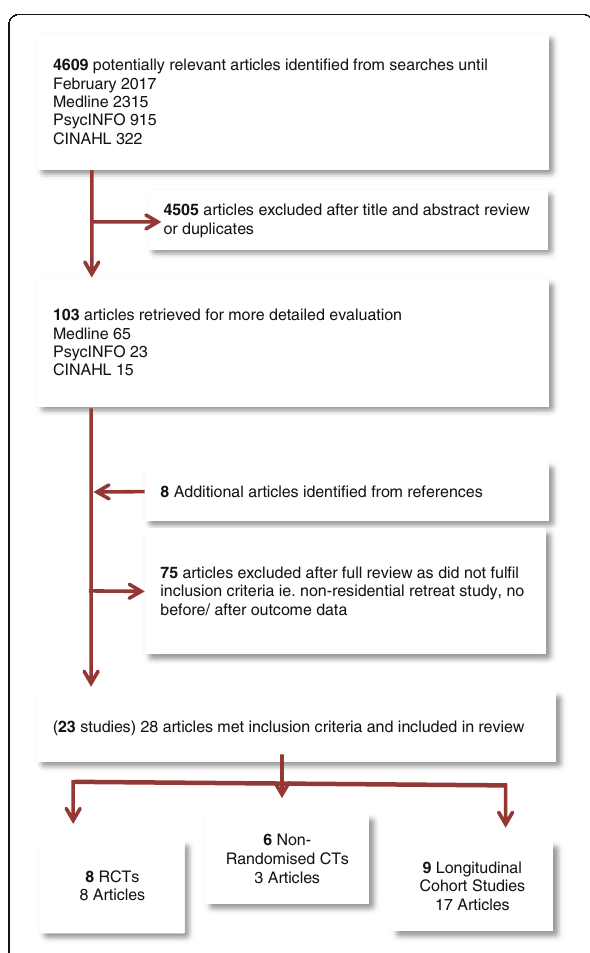
Bias due to Bias in selection confounding of